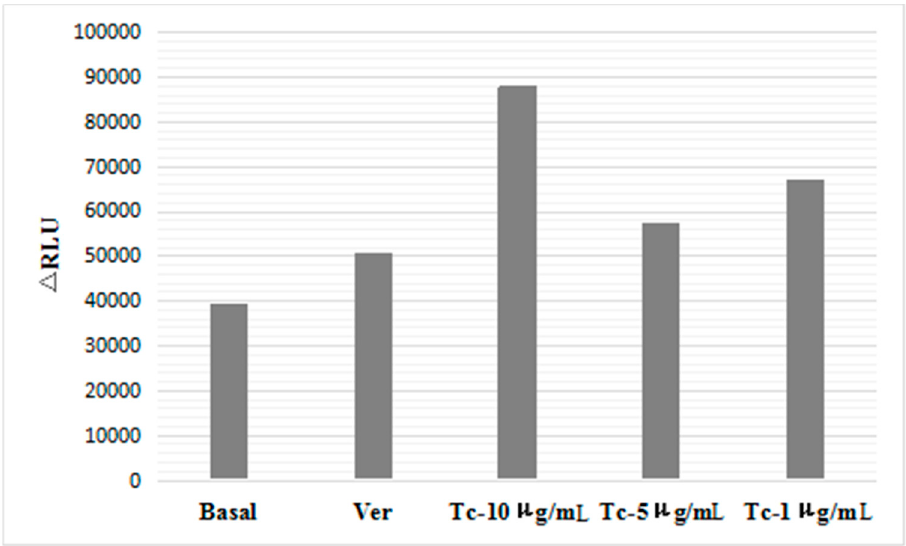
Figure 3. Fluorescence Intensity of control groups ( n = 4).